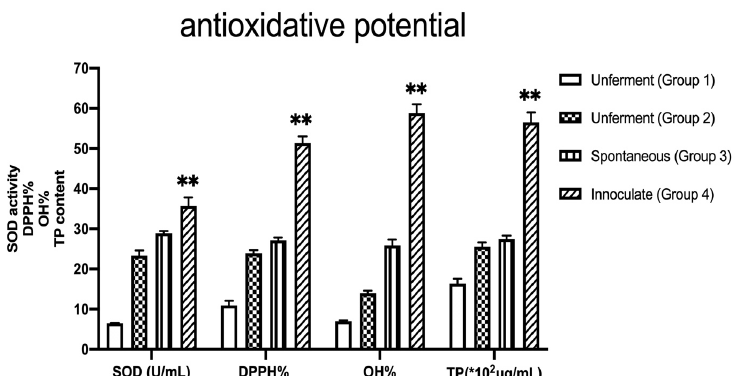
Figure 6. Antioxidative profiles of herbal broths from all four treatments. The data represent the means ± SD ( n = 3). **, p < 0.01.